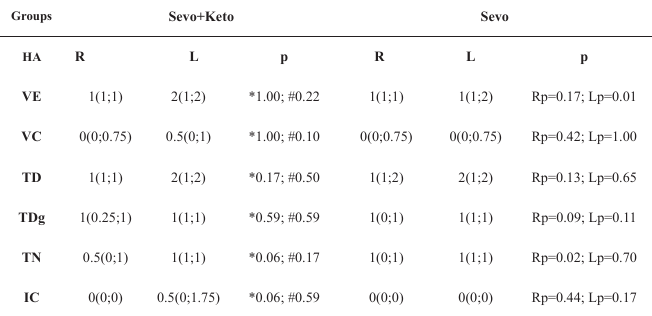
TABLE 1 - Scores of histological analysis (HA): vascular ectasy (VE), vascular congestion (VC), tubular dilation (TD), tubular degeneration (TDg), tubular necrosis (TN), inflammatory cells (IC) (data reported as median, 25 th and 75 th percentile) in the right (R) and left (L) kidneys according to group, sevo+keto or sevo.